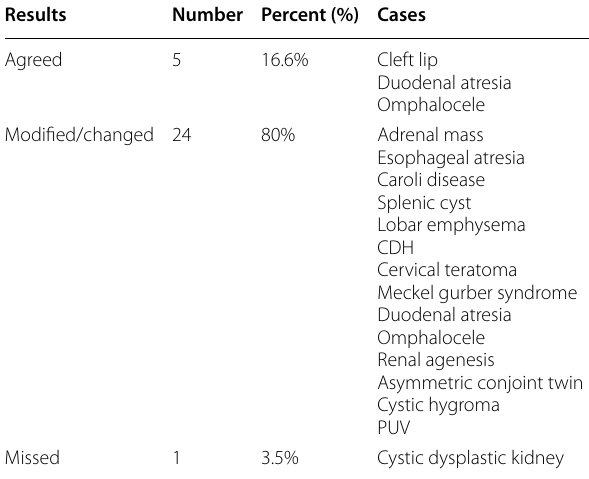
Table 2 Results of prenatal MRI about prenatal US finding